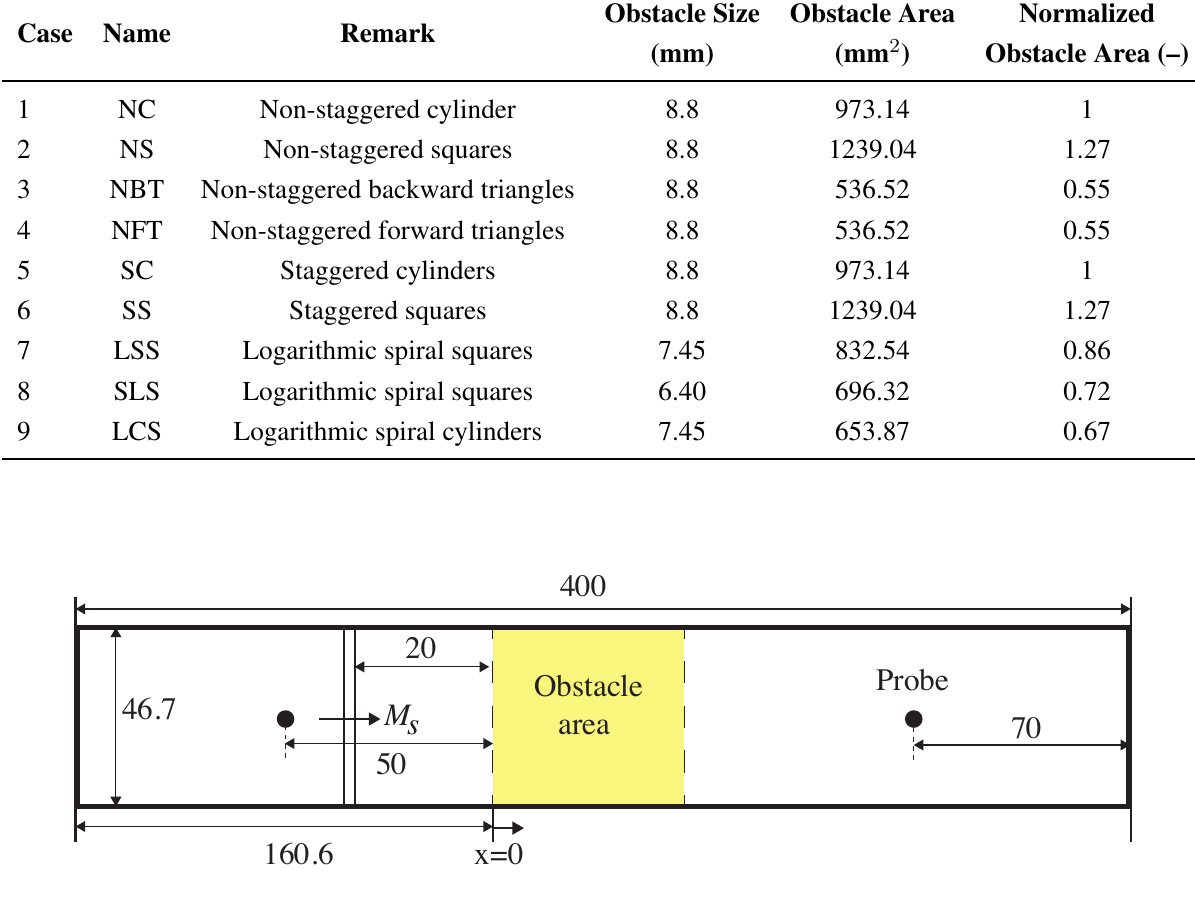
Figure 3. Simulation setup. Distances in mm. Not to